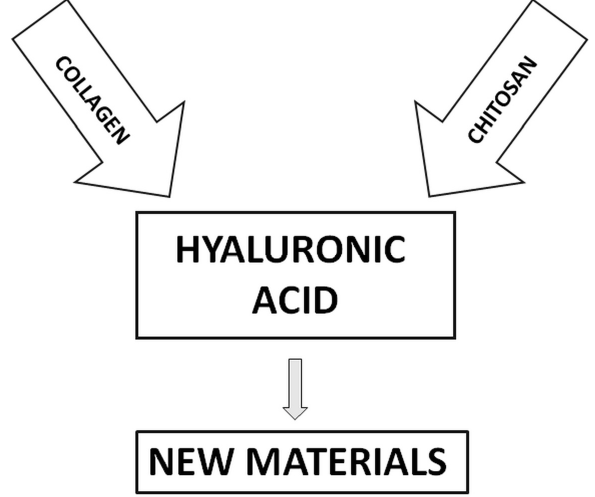
Figure 4. Scheme of preparation of the materials based on hyaluronic acid, collagen, and chitosan.